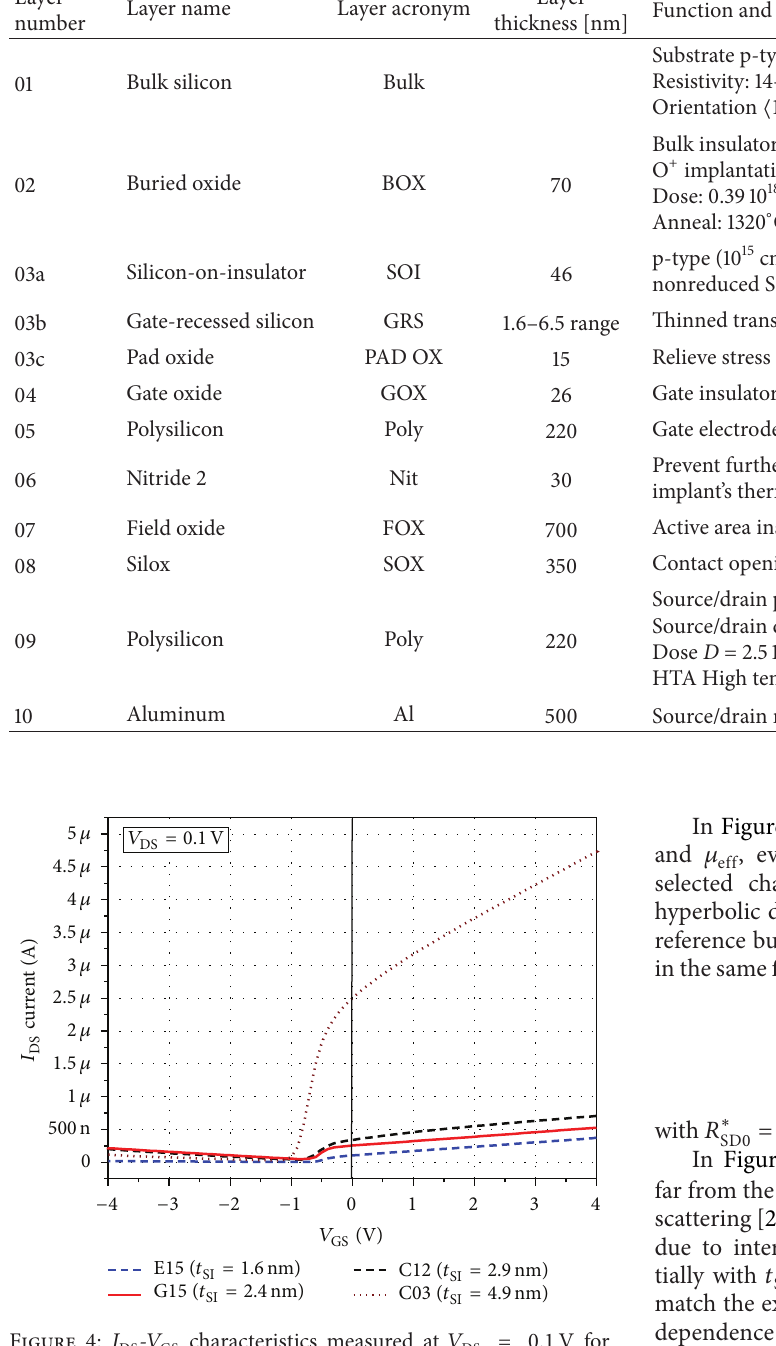
Figure 4: 𝐼 - 𝑉 characteristics measured at 𝑉 DS GS four NSB devices (dices E15, G15, C12, and C03) having a channel ) of 1.6, 2.4, 2.9, and 4.9 nm, thickness ( 𝑡 SI